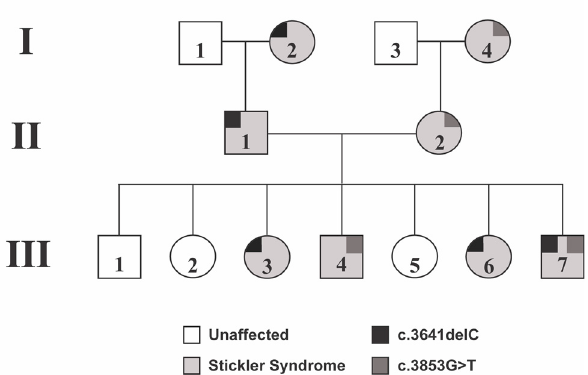
Figure 1. Three-generation pedigree. A pedigree showing affected and non-affected family members, along with specific mutations within COL2A1. Of note, Patient III-7 carries both maternally and paternally inherited mutation Table 1. Ocular and systemic characteristics in family members with Stickler syndrome type I Clinical findings of the eight patients with Stickler syndrome show the phenotypic variability with the family of interest, including ocular, systemic, and genetic findings.